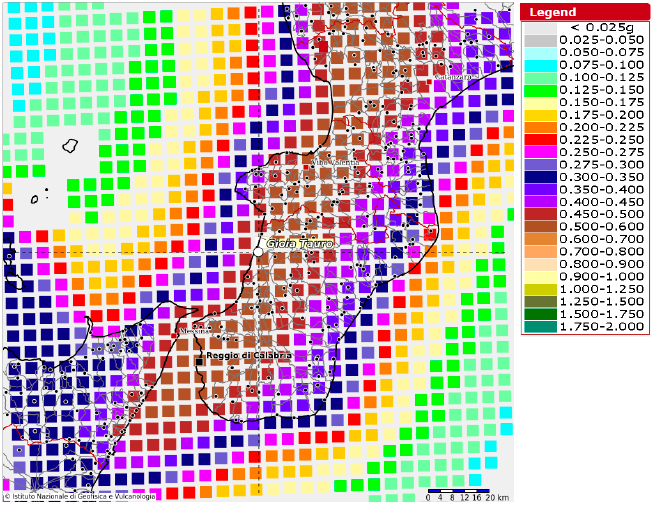
Figure 10. Seismic hazard map (in terms of PGA rock ) around Gioia Tauro corresponding to 2% exceedance in 50 years (adopted from the MPS04 model, http://esse1.mi.ingv.it, accessed on 1 June 2022).